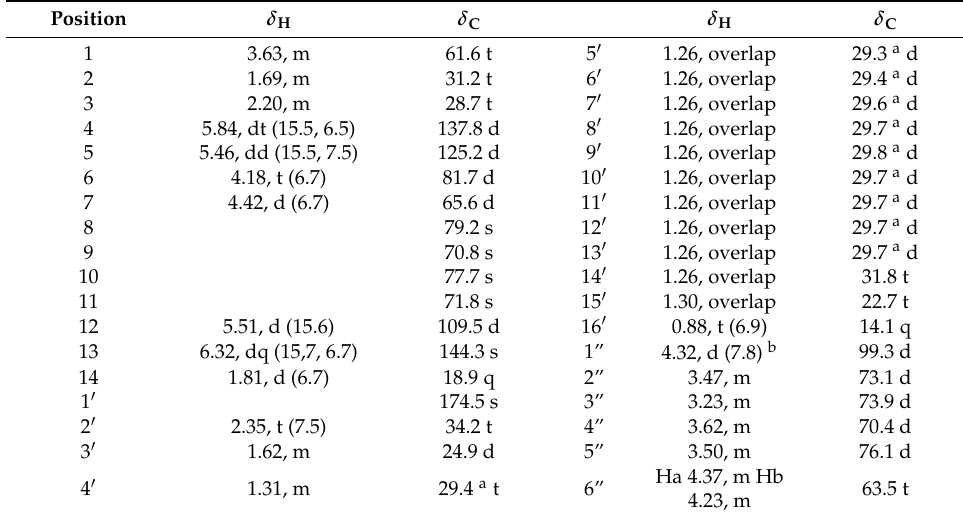
Table 2. 1 H- (600 MHz) and 13 C-NMR (150 MHz) data of 2 in CDCl 3 ( δ in ppm, J in Hz).